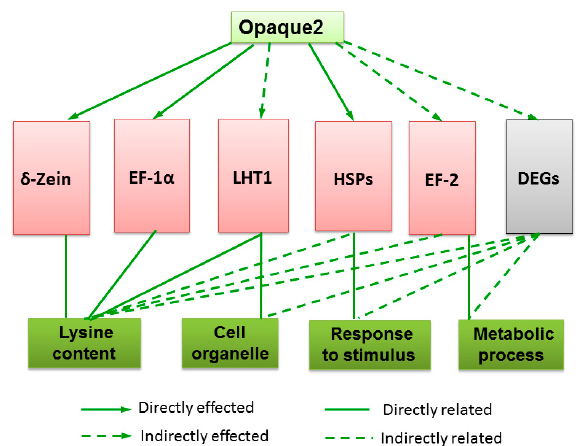
Figure 8. A proposed model of the transcriptional regulatory framework for the O2 gene in waxy maize. Solid arrows, directly effected; dotted arrows, indirectly effected; full lines, directed related; dotted lines, indirectly related.